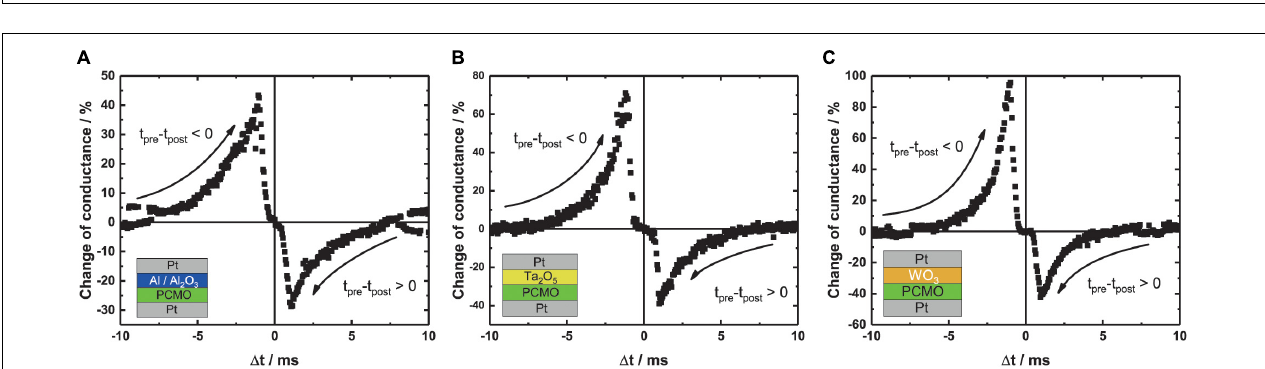
FIGURE 2 | (A – C) The Weibull plot of the combined cycle to cycle variability (c2c) and device-to-device variability (d2d) for the three different stacks, (A) Al 2 O 3 , (B) Ta 2 O 5 , and (C) WO 3 , indicated by the stack in the lower right corner. For each stack, 10 different devices with each up to 100 cycles have been investigated.